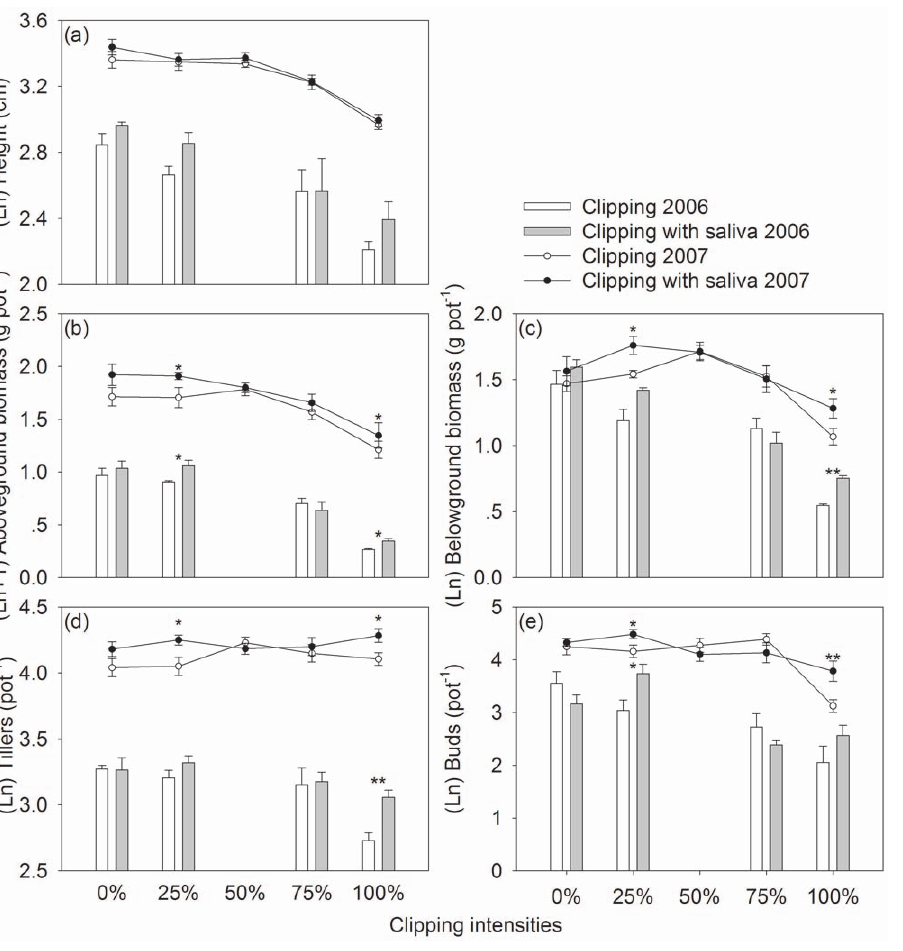
Figure 1. Effects on regrowth. The effects of clipping and saliva on height, aboveground biomass, belowground biomass (BGB), tillers and buds (back-transformed from the log scale) of Leymus chinensis both on 17 August 2006 and 20 August 2007. There are four clipping levels (0%, 25%, 75% and 100% of aboveground shoots) in 2006 and five ones (0%, 25%, 50%, 75% and 100%) in 2007. Bars represent standard errors. **, P , 0.05; *, P , 0.01.